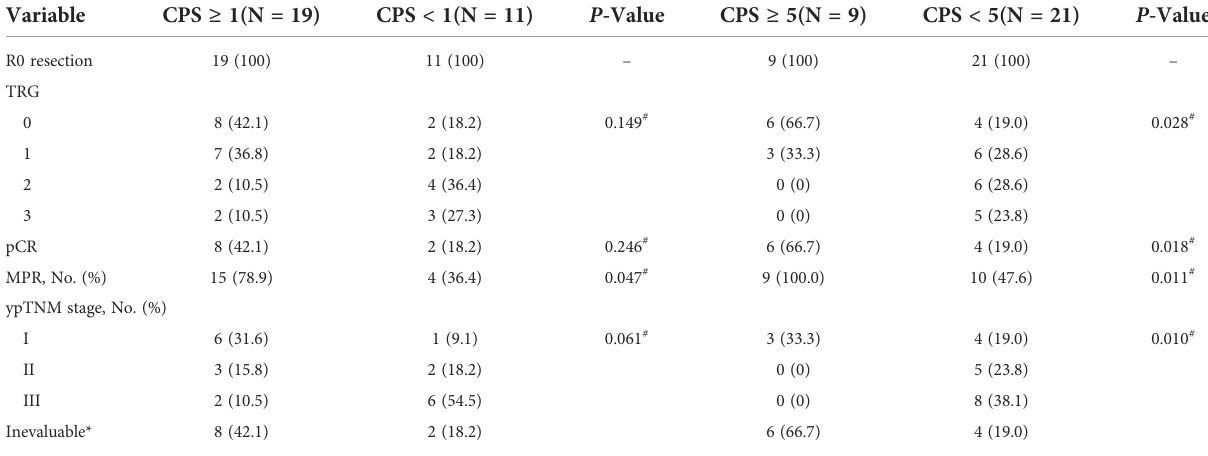
TABLE 2 Clinicopathological results of 30 patients after surgery. No.